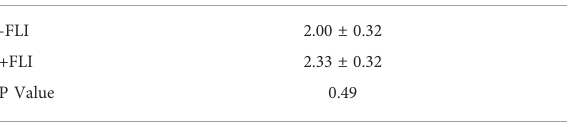
TABLE 1 Average number of conceptuses collected on day 15.